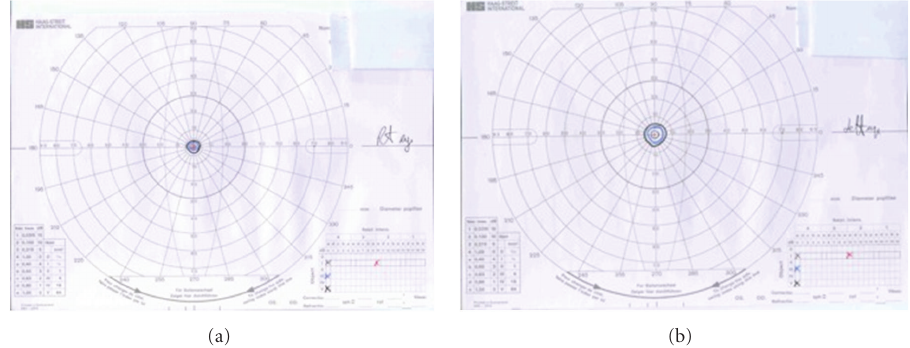
Figure 1: (a) Goldman Visual field of the right eye. Gross visual field constriction. (b) Goldman visual field of the left eye. Gross visual field constriction.